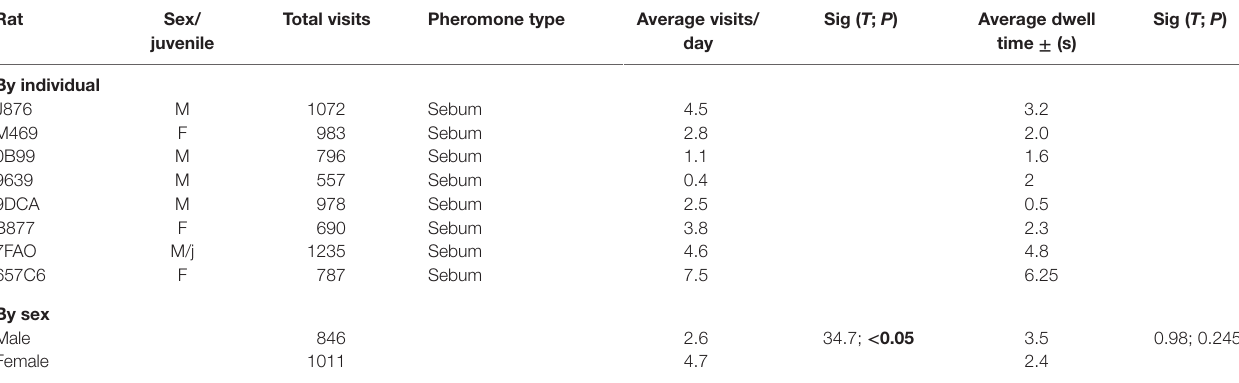
tABlE 3 | recruitment by pheromone-type.